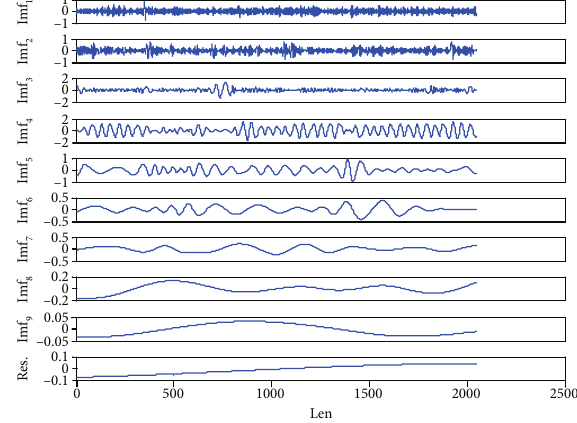
Figure 9: IMFs of signal when fl utter